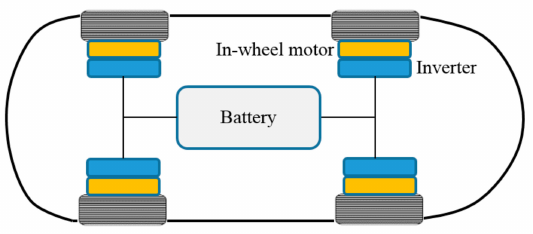
Figure 1. The direct-drive electric vehicle with in-wheel